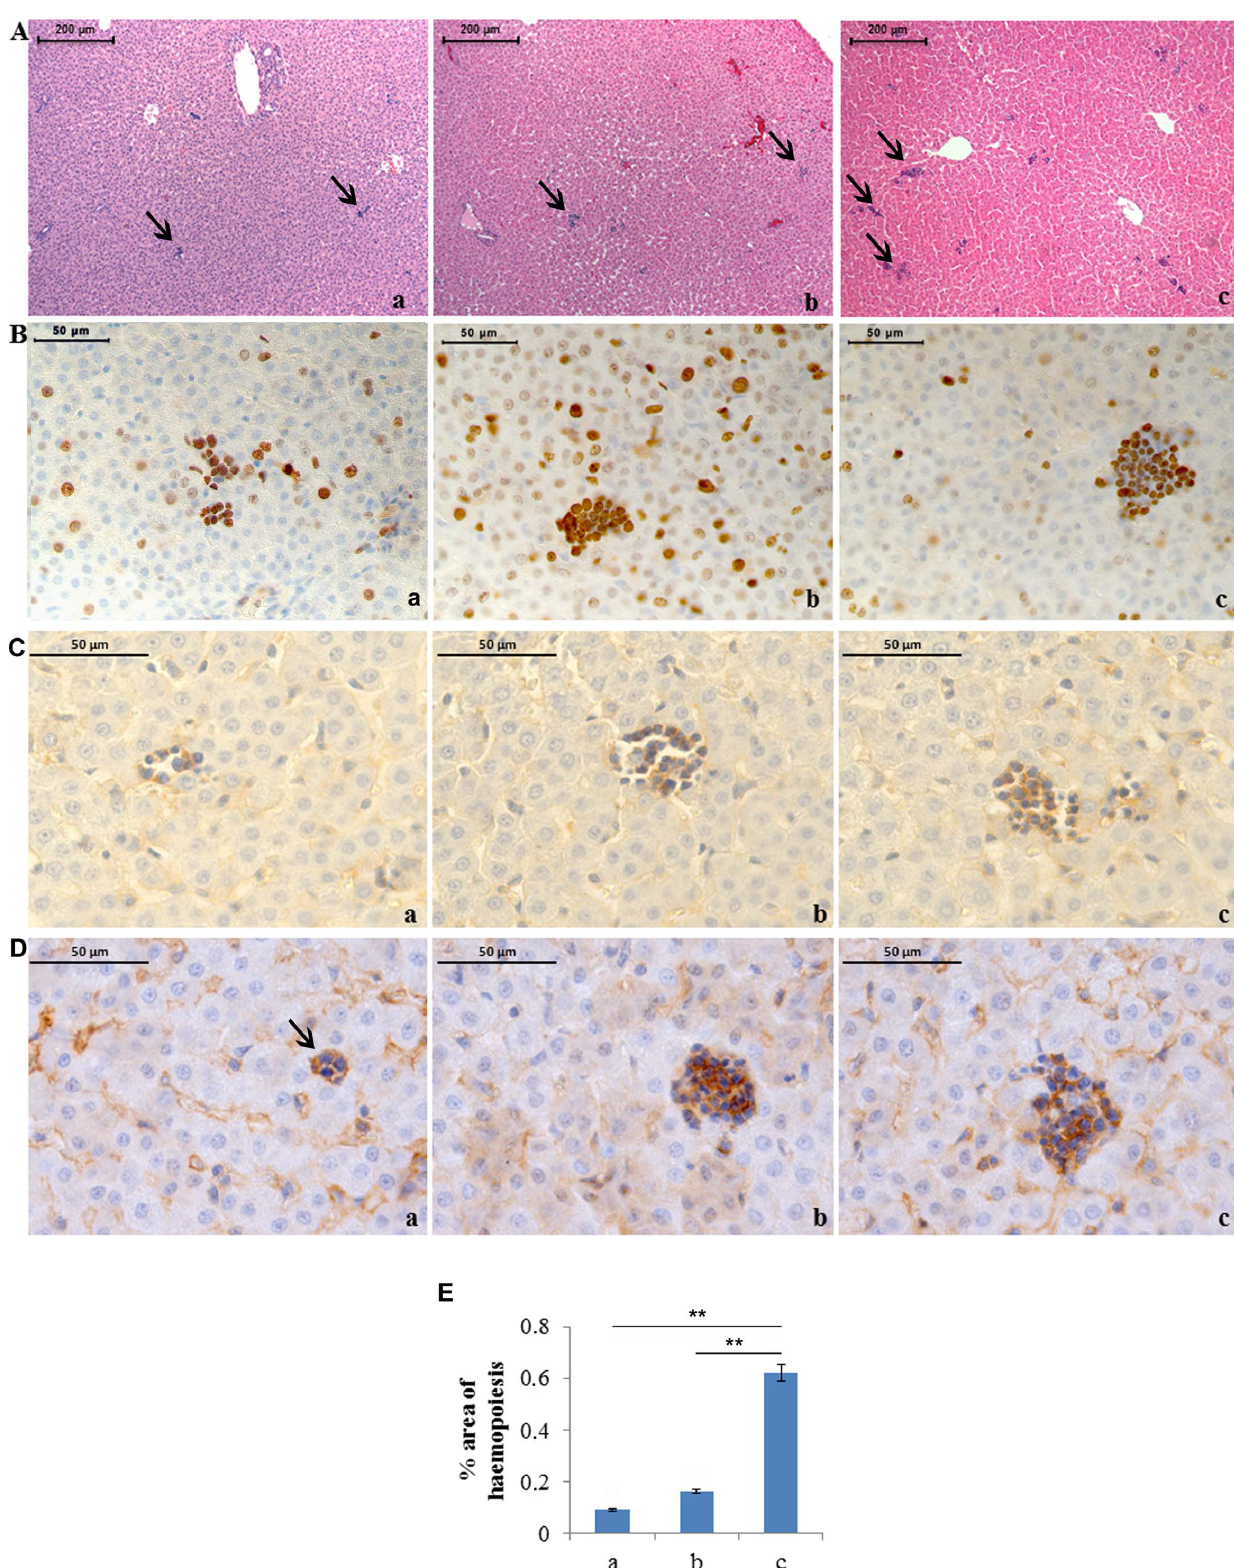
Figure 1. Severe hyperoxia increases liver haemopoiesis. A) Haematoxylin-eosin staining of neonatal rat livers exposed to moderate and severe hyperoxia. a) ambient air; b) 60% hyperoxia; c) 95% hyperoxia. Arrows indicate haemopoietic foci. Scale bar: 200 m m, magnification 10x. B) Anti-ki67 immunohistochemistry showing diffuse positivity of haemopoietic cells. Scale bar: 50 m m, magnification 40x. C) Anti-CD34 immunohistochemistry showing diffuse positivity of haemopoietic cells. Scale bar: 50 m m, magnification 63x. D) Anti-CD45 immunohistochemistry